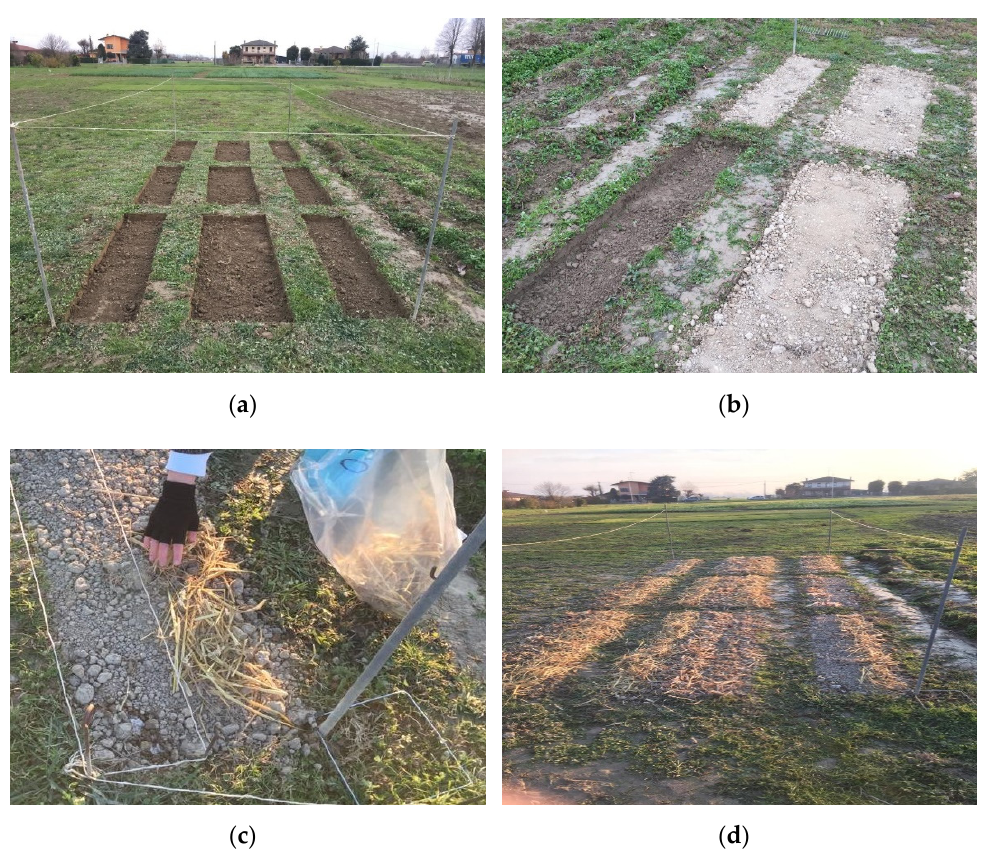
Figure 1. Experimental site; ( a ) 5 cm of soil removed; ( b ) redistribution of soil after sterilisation; ( c ) sowing and covering with residues; ( d ) final appearance.